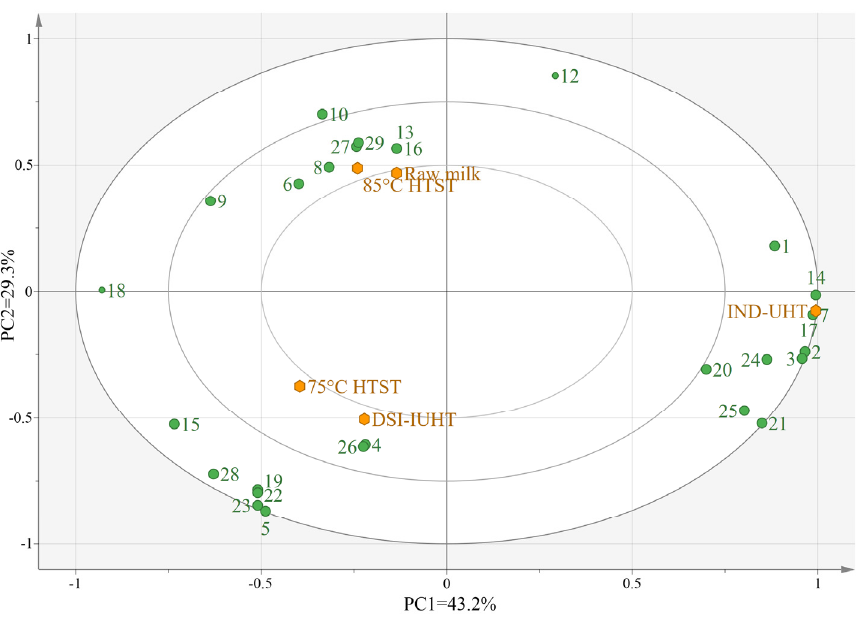
Figure 5. Principal component analysis (PCA) of the five milk samples subjected to SPME. The orange plots represent the five milk samples. (The numbers correspond to VCs is shown in Table 2.)